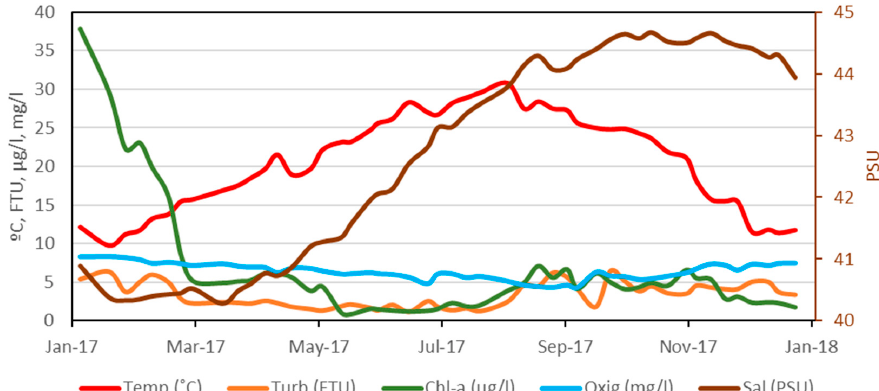
Figure 3. Annual evolution during 2017 at central site A3 of environmental variables: Temperature (Temp, ◦ C), Turbidity (Turb, FTU), Chlorophyll-a concentration (Chl-a, µ g / L), Dissolved Oxygen (Oxig, mg / L), and Salinity (Sal, PSU).